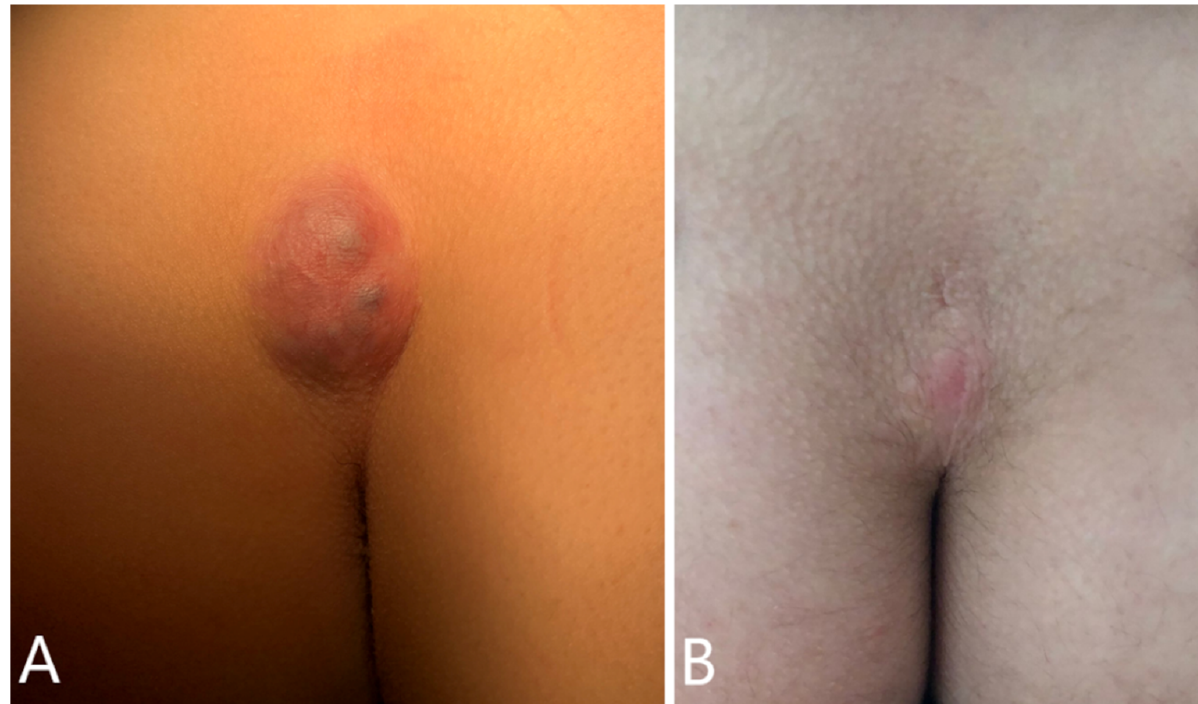
Figure 1. Visible subcutaneous sacrococcygeal swelling, firmly fixed to overlying discolored intact skin, and loosely adherent to the coccyx ( A ). Postoperative appearance of the sacrococcygeal region 1 year after surgery, showing a well-healed scar and normal skin color ( B ).